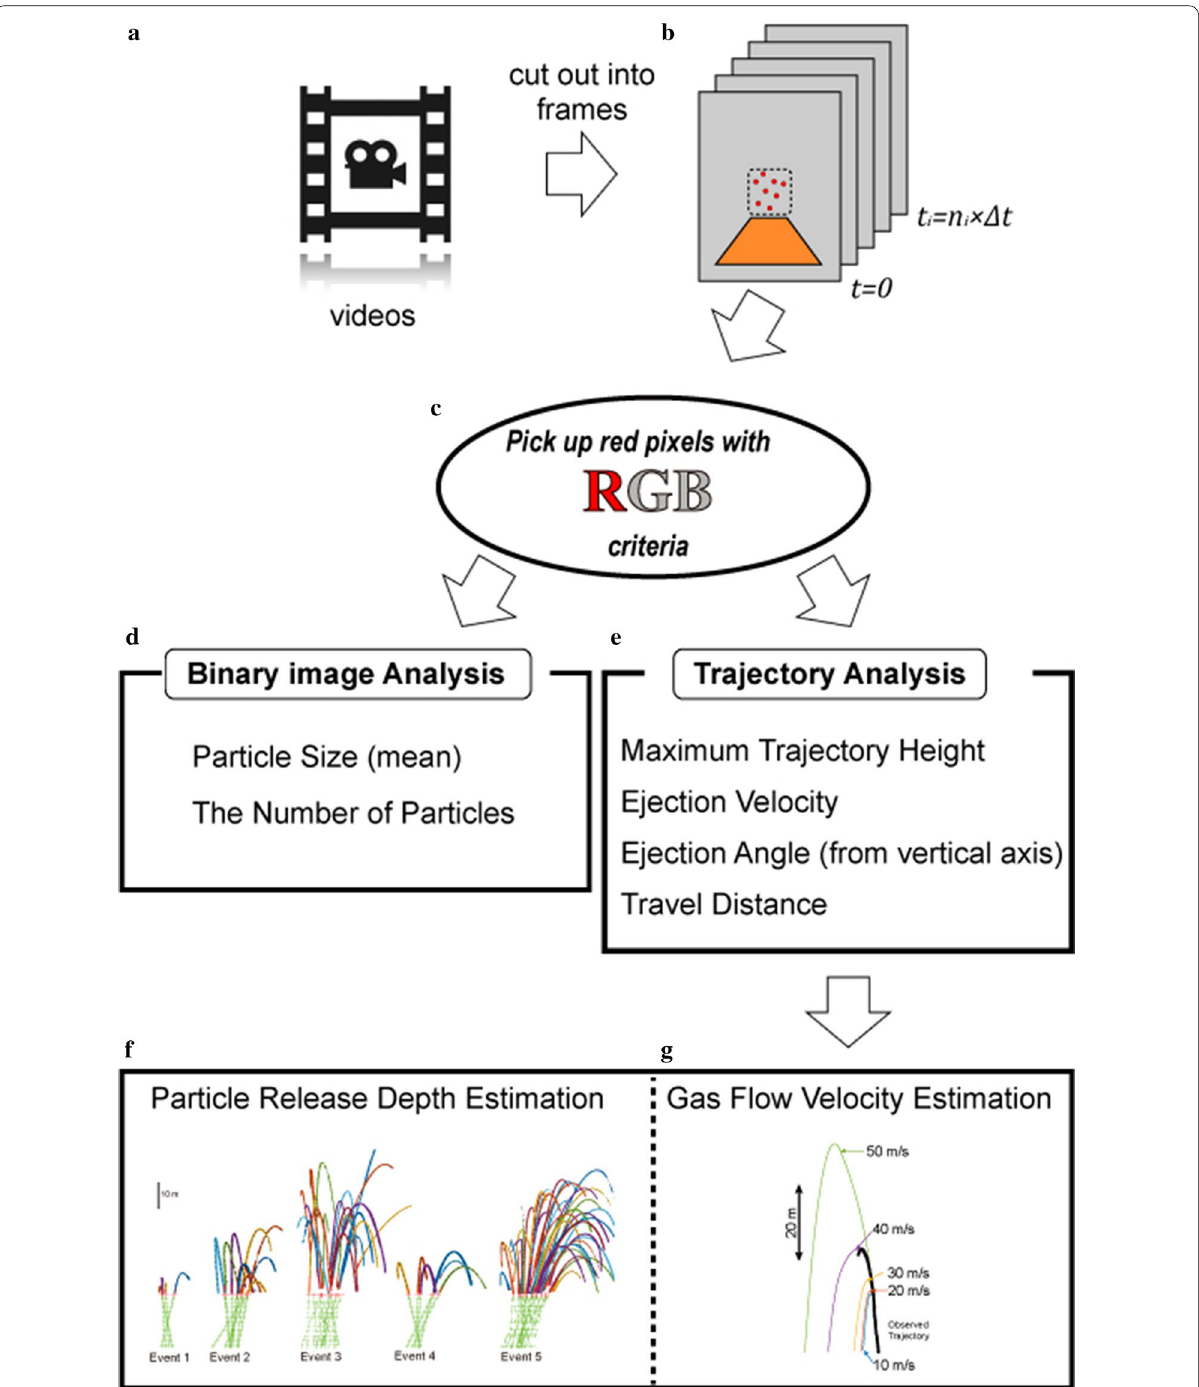
Fig. 3 Flowchart of the whole image